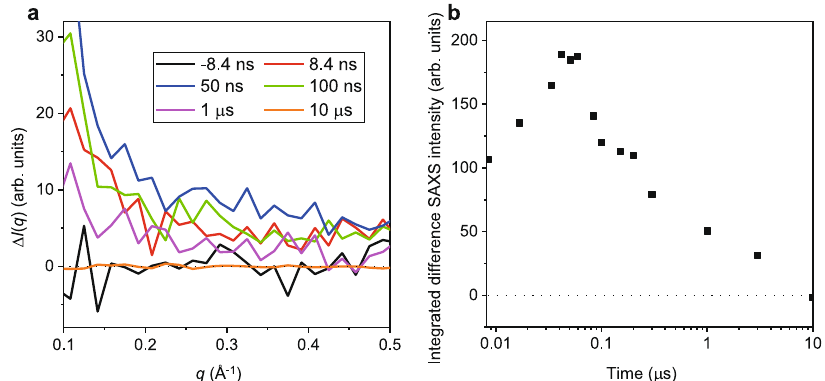
Fig. 5 | Small-angle x-ray scattering results. a The difference between the unpumped and pumped scattering curves at various time delays in the SAXS region. b Time- dependent integrated difference SAXS intensity from q =0.1 to 0.3 Å − 1